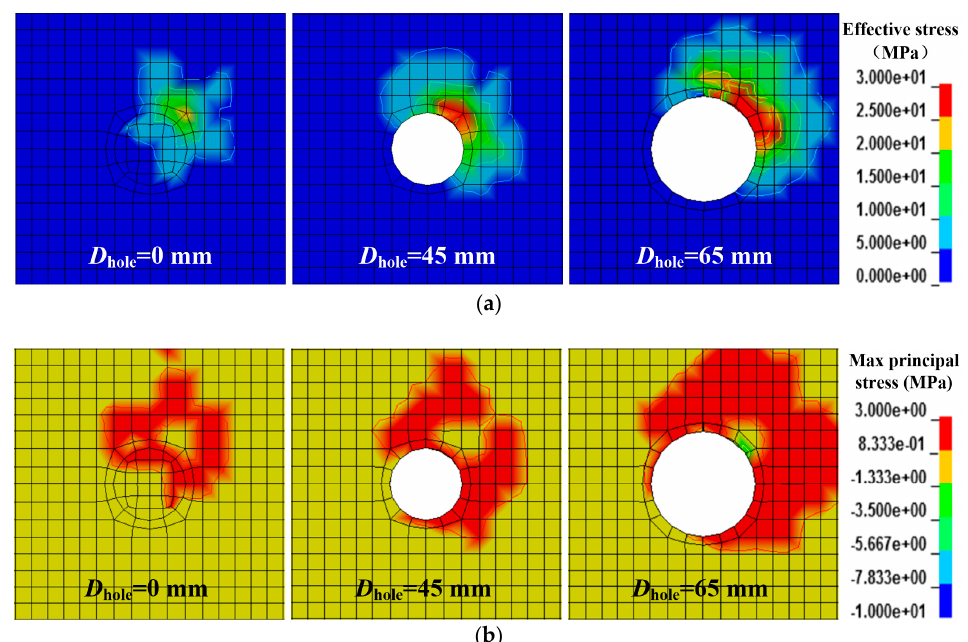
Figure 11. ( a ) Effective stress contours and ( b ) maximum principal stress contours of the rocks containing holes with different diameters.